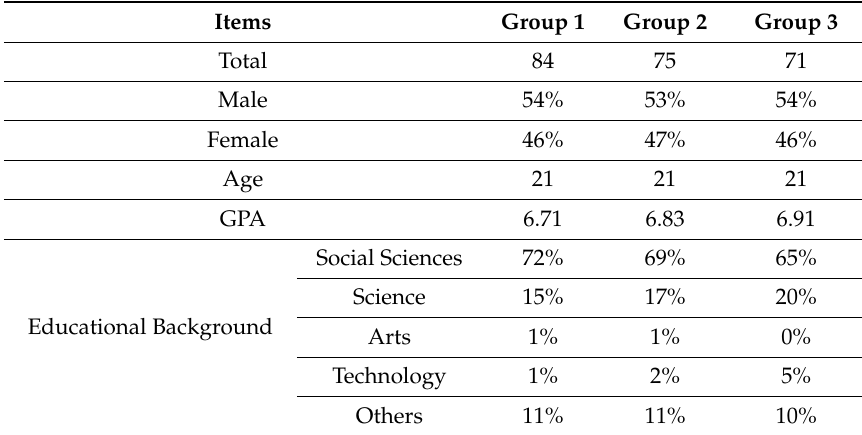
Table 1. Demographic data of the overall 230 participants in 3 groups. Items Group 1 Group 2 Group 3